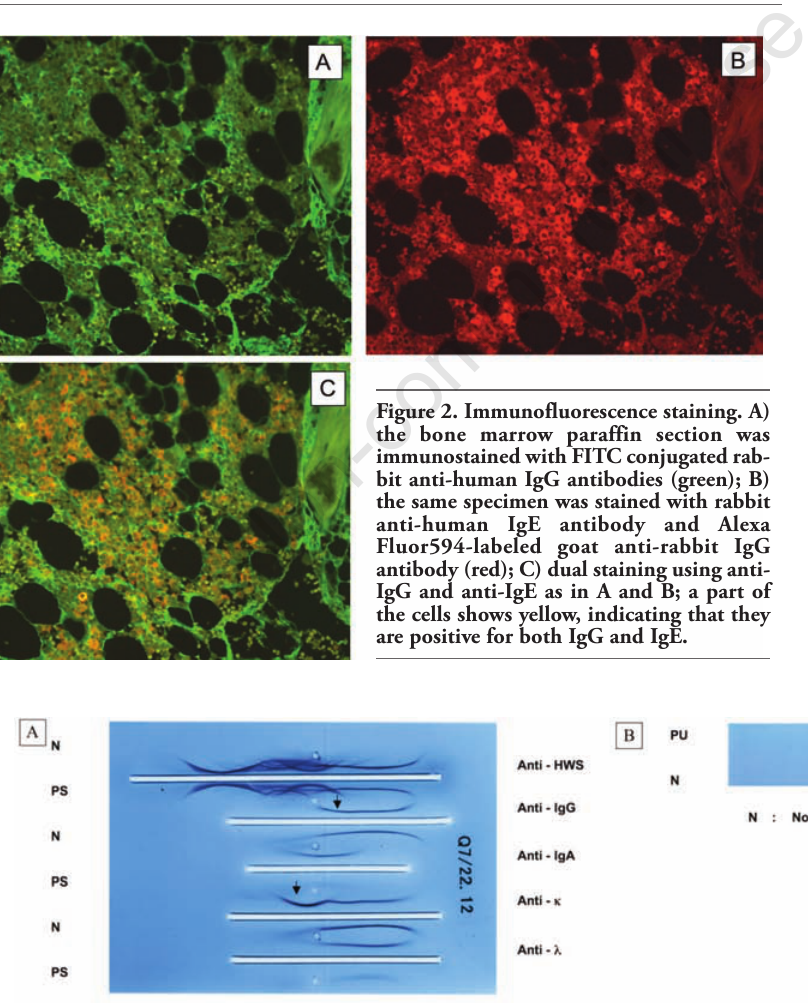
Figure 1. Bone marrow aspiration. Myeloma cells were detected at 55.5% (Wright-Giemsa stain ¥ 100). Myeloma cells showed strong positivity for IgE and κ (immunostain ¥ 60) but few cells were positive for IgG (immunostain ¥ 80).